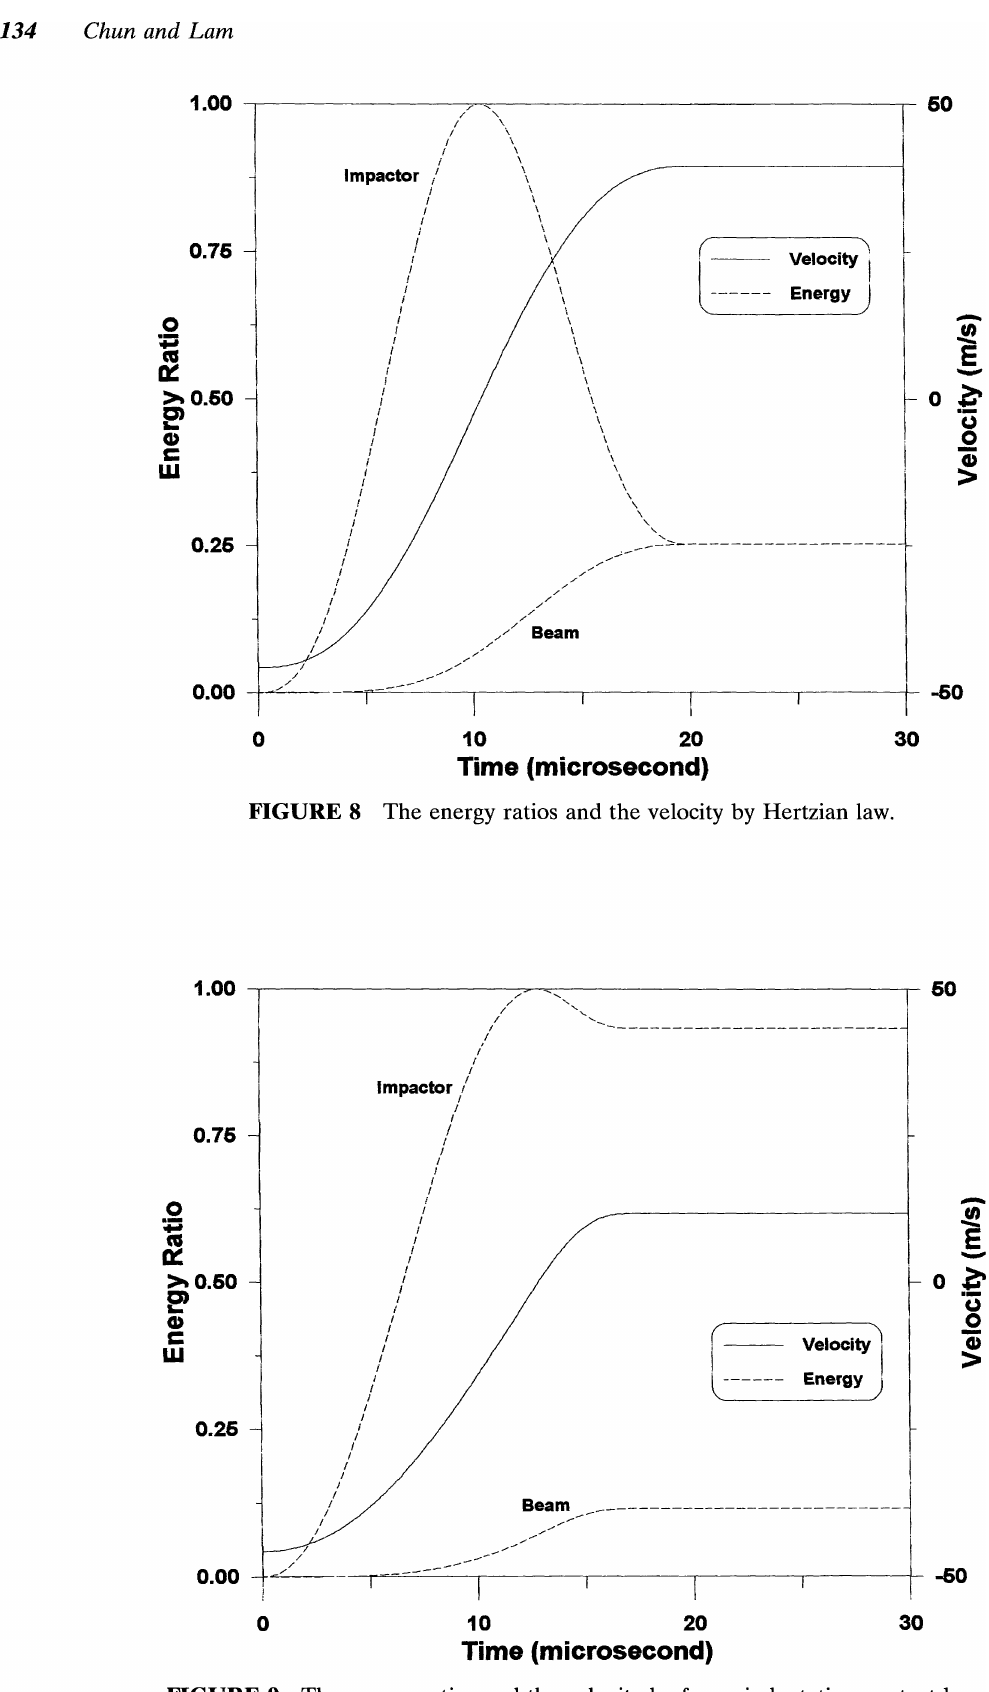
FIGURE 9 The energy ratios and the velocity by force-indentation contact